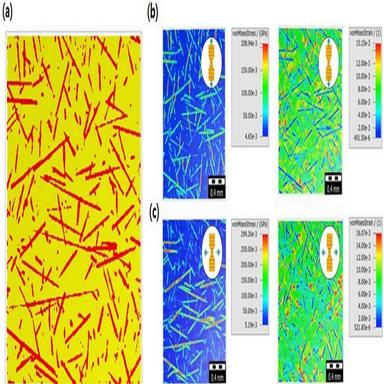
Color map images of the Von Mises stress/strain for the (a) extended regions of the transverse specimen. Simulation images of the transverse specimen when the uniaxial load was applied (b) in the Z direction parallel to the fiber orientation and (c) in the X direction perpendicular to the fiber orientation. (For interpretation of the references to color in this figure legend, the reader is referred to the Web version of this article.)